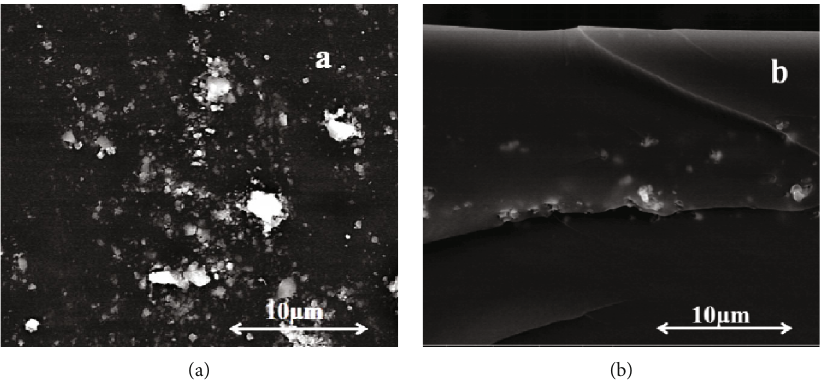
Figure 5: SEM images of rare earth UV-cured composite: (a) surface morphology and (b) section morphology.